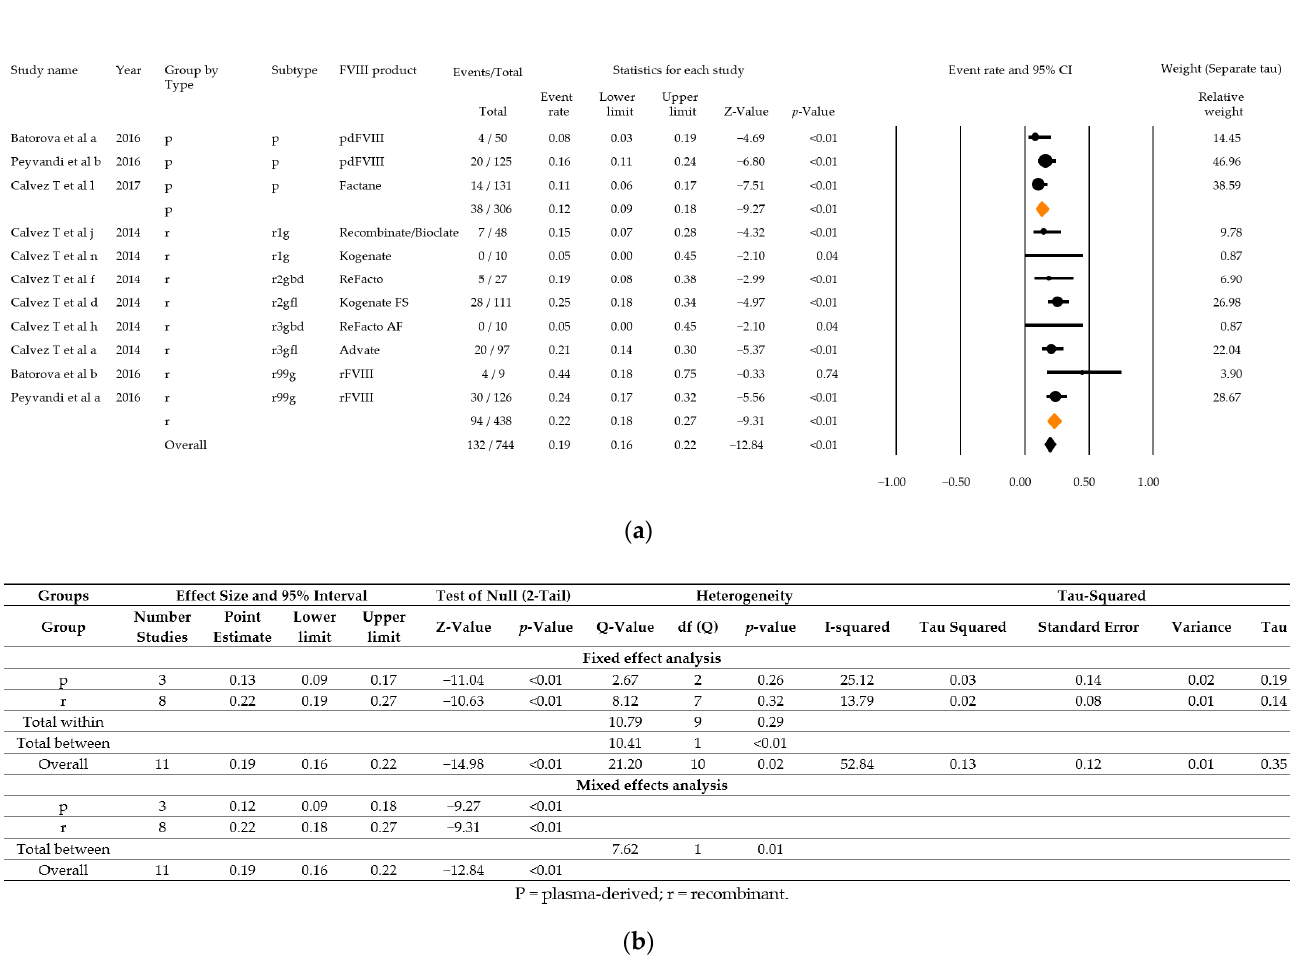
Figure 7. Analysis results for high severity disease and high titre inhibitor patients of the three relevant studies that fulfil all parameters as demanded in the ClinGL: Forest plot ( a ), Basic statistics ( b ). p = plasma-derived; r recombinant; r1g = recombinant 1, generation full length; r2gfl = recombinant 2, generation full-length; r2gbd = recombinant 2, generation B domain deleted; 3gfl = recombinant 3, generation full-length; r3gbd = recombinant 3, generation B domain deleted; rg99 = recombinant not further specified.